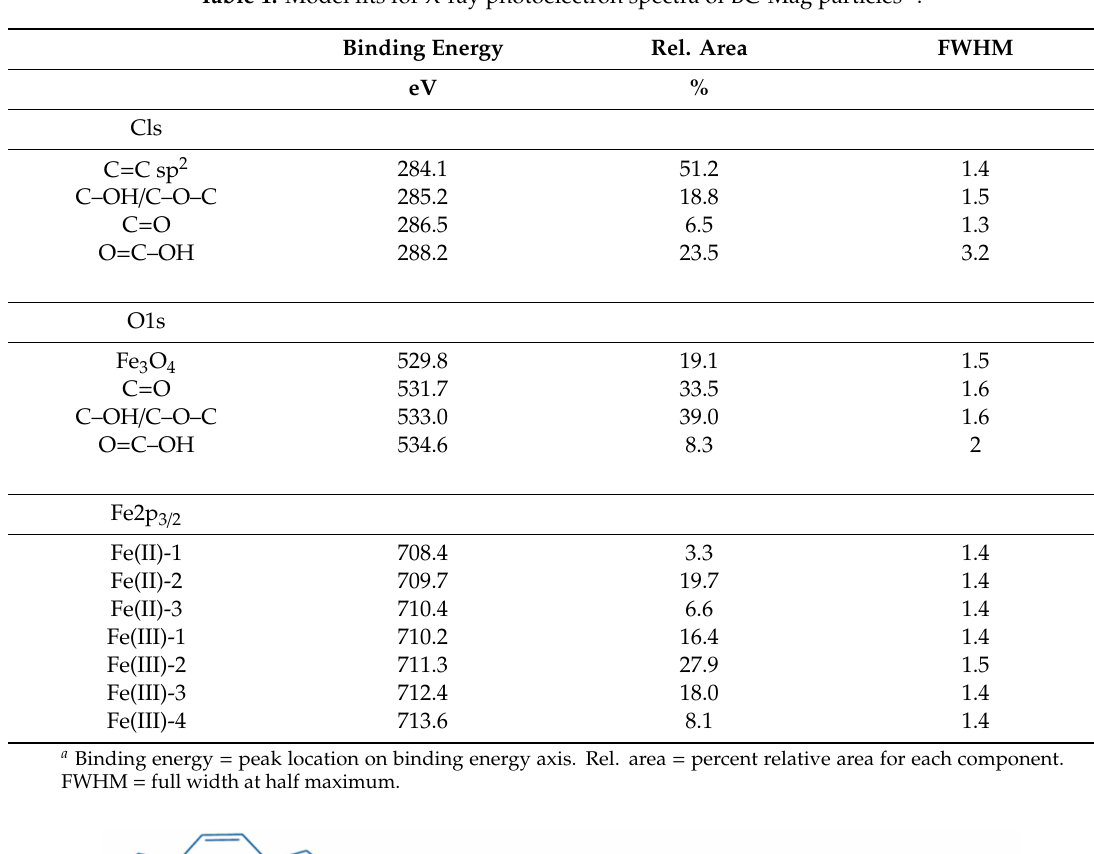
Table 1. Model fits for X-ray photoelectron spectra of BC-Mag particles a .